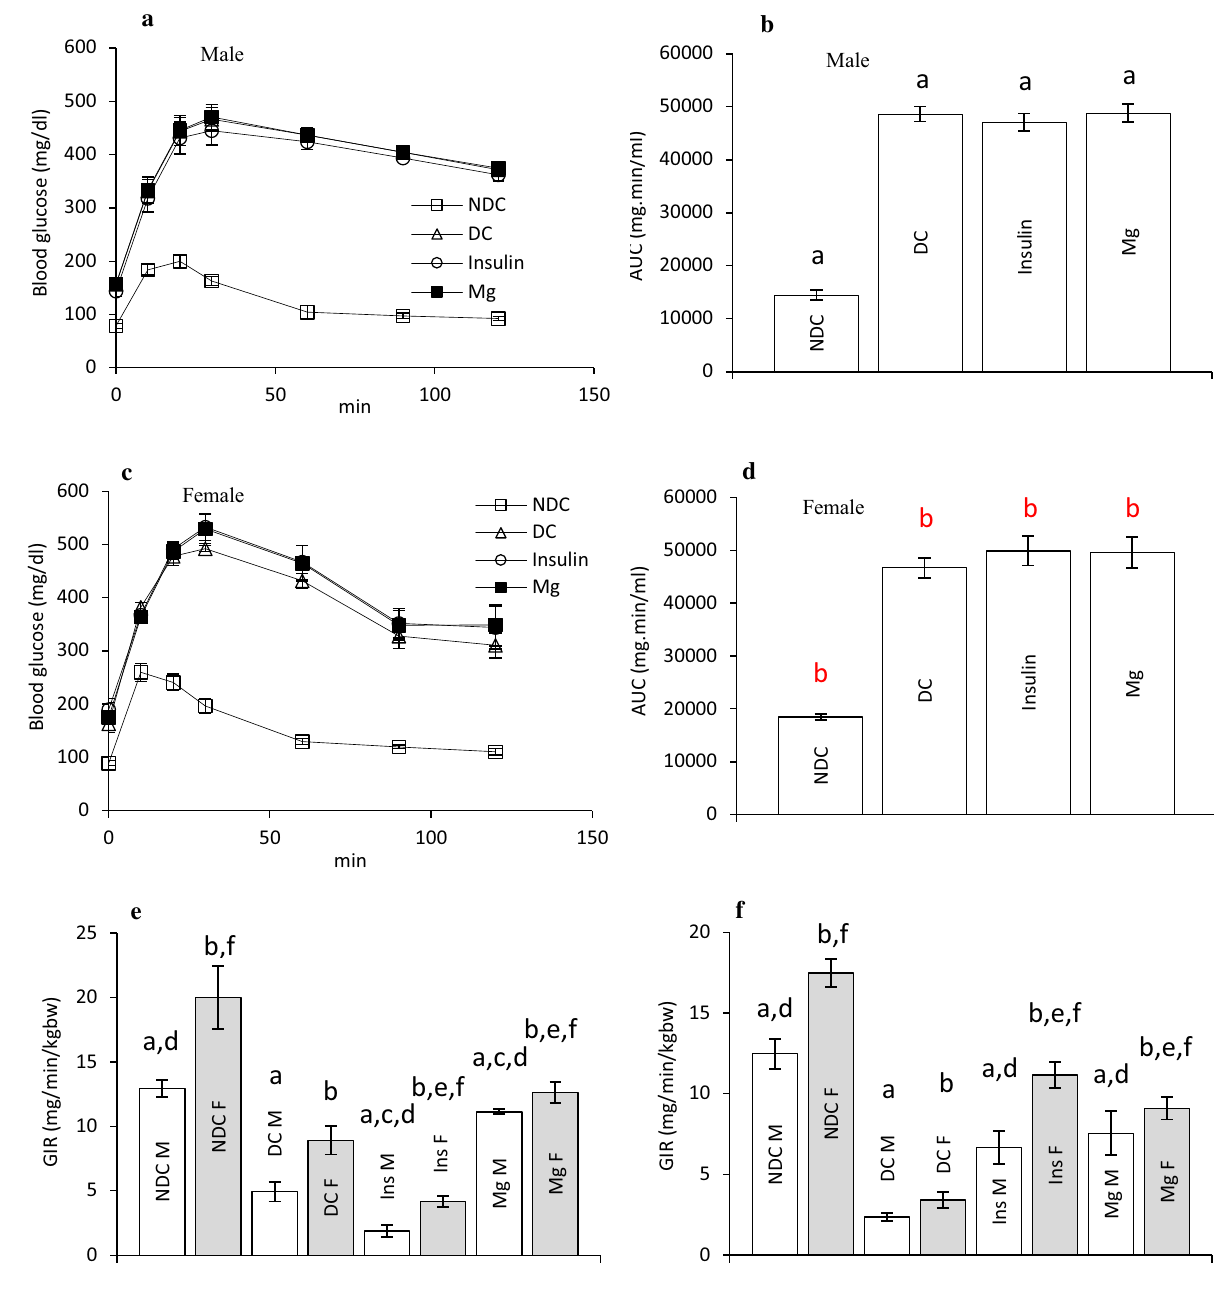
Figure 2. Comparison of intraperitoneal glucose tolerance test (IPGTT) in male ( a ) and female ( c ) before intervention, the area under the glycemic curve (AUC) ( b in male and d in female), glucose infusion rate (GIR) in parents ( e ) and their offspring ( f ) in non-diabetic control group (NDC) was fed with normal diet, to preform IPGTT, the animals were fasted overnight for 15 h and in the day after, the animals received 1.5 g/kg glucose via IP injection. And the blood glucose was measured by using of glucometer (Ascensia ELITE XL glucometer) through a tail vein at 0, 20, 30, 40, 60, 90, and 120 min after glucose administration. diabetic group received high-fat diet and 35 mg/Kg STZ (D), diabetic animals treated with insulin (2.5 U/Kg two time per day) (Ins) and diabetic animals treated with 10 g/l magnesium sulfate via drinking water (Mg). 10 rats in each group and data are expressed as mean ± SEM. a Significant difference between D male group and other male groups ( P < 0.0001). ( b ) Significant difference between D female group and other female group ( P < 0.001). ( c ) Significant difference between male Mg group and male insulin group ( P < 0.001). ( d ) Significant difference between male NDC and male Mg and male insulin groups ( P < 0.001). ( e ) Significant difference between female Mg group and female insulin group ( P < 0.001). ( f ) Significant difference between female NDC and female Mg and female insulin groups ( P <